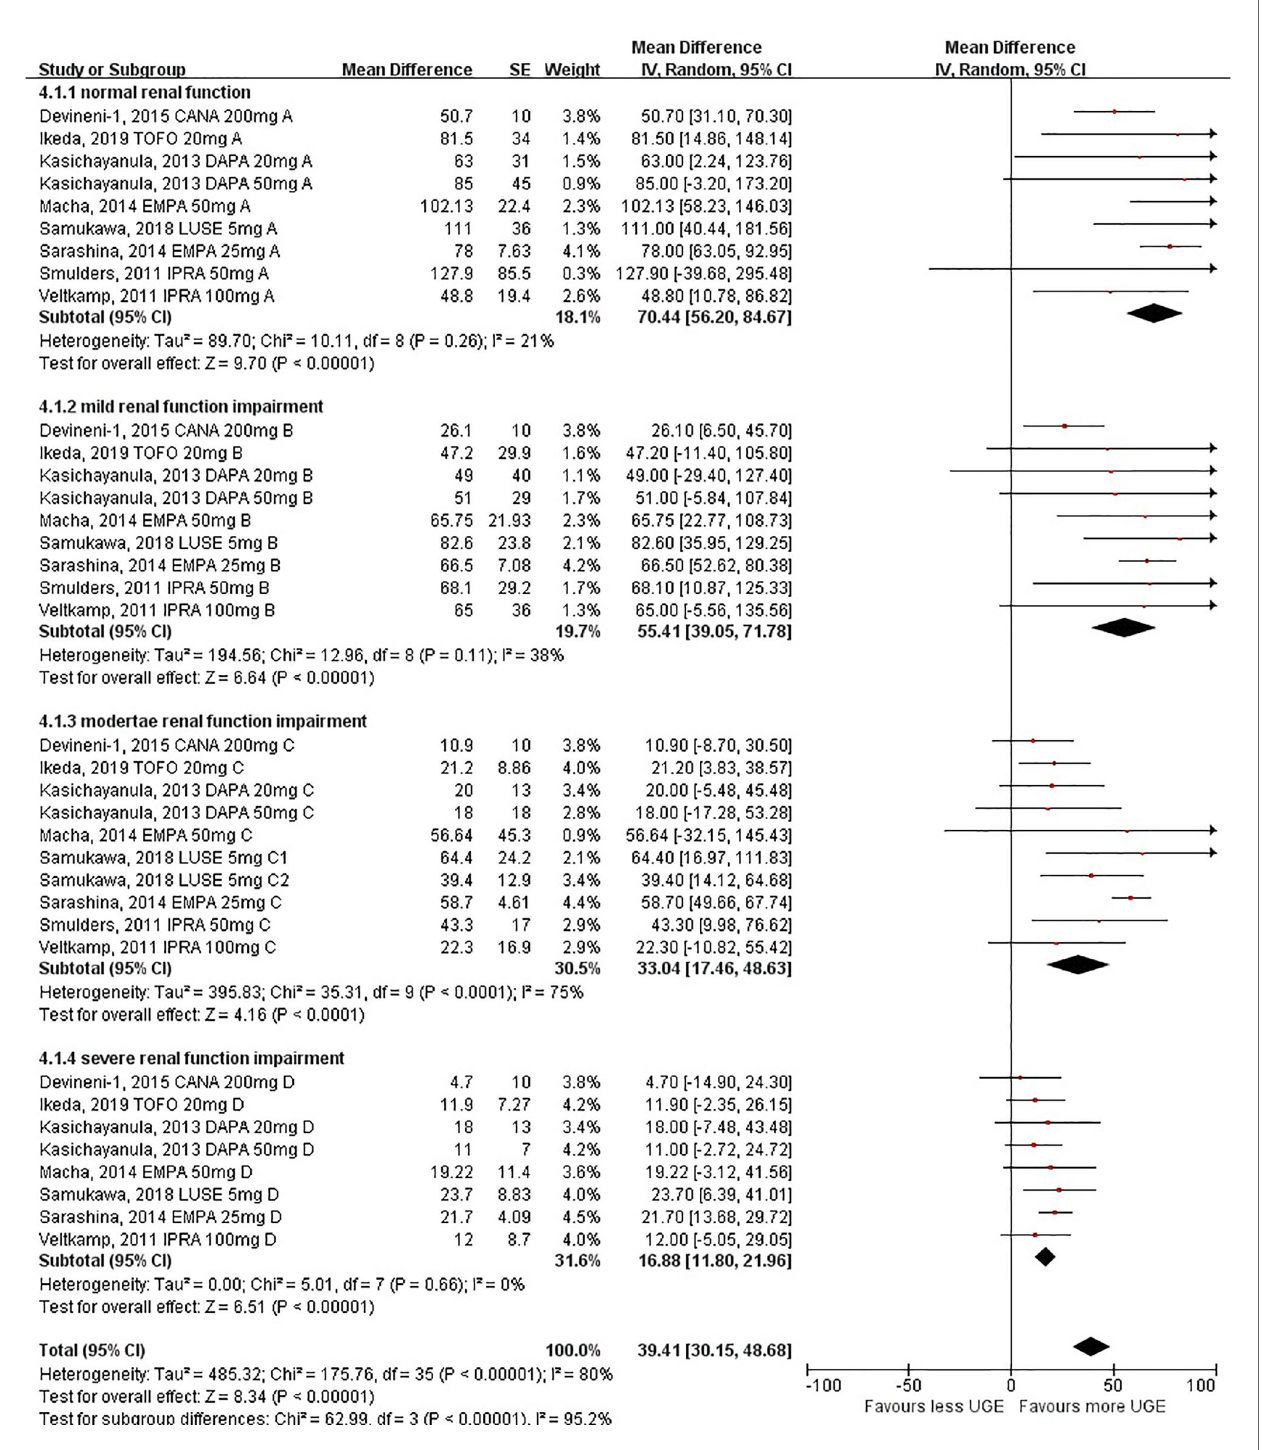
FIGURE 2 | Post-treatment urinary glucose excretion in patients with different levels of renal function.